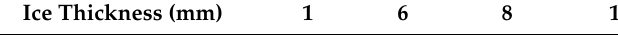
Table 4. E ff ect of ice thickness on de-icing